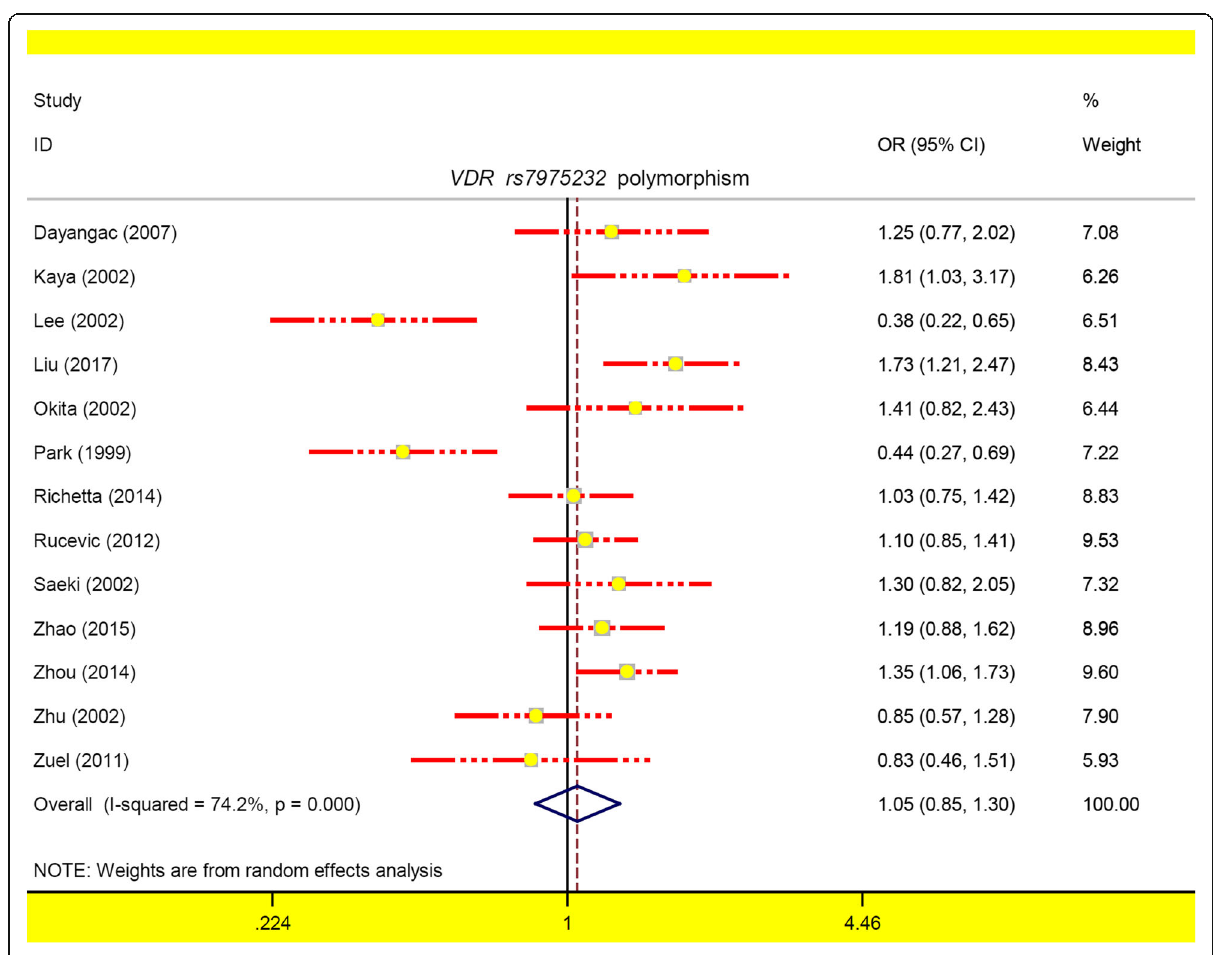
Fig. 2 The forest plot for VDR rs7975232 polymorphism under the allele